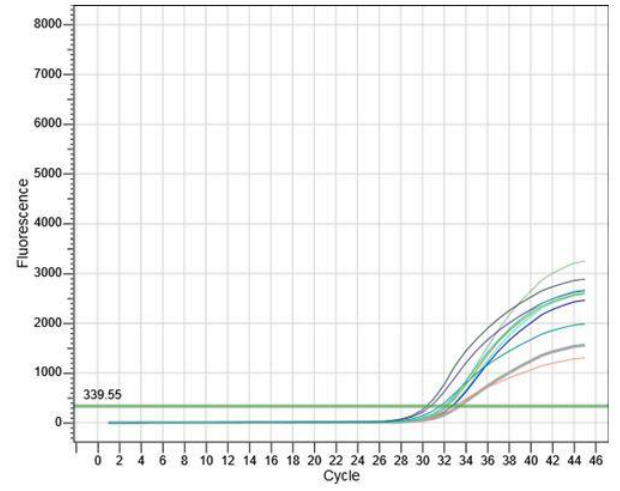
Fig. 2: shows the threshold curve of positive samples of EHV-1 (their Ct ranged from 32- 33.5).